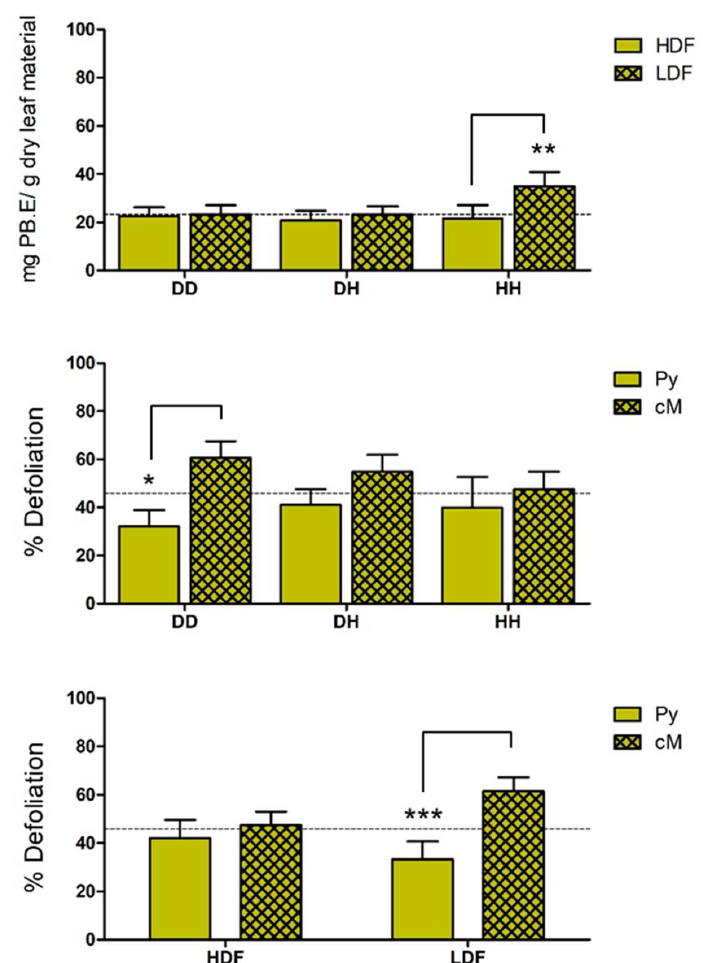
Figure 4. Results from ANOVA and pairwise comparisons between CT and herbivore susceptibility depending on plant singularities (like in Figure 3). The bar graph represents the mean and standard error for a confidence interval of 95%. The dashed line indicates the mean value of the measured samples. Confidence levels were assessed by two-way ANOVA: * 95%, ** 99%, *** 99.9%.